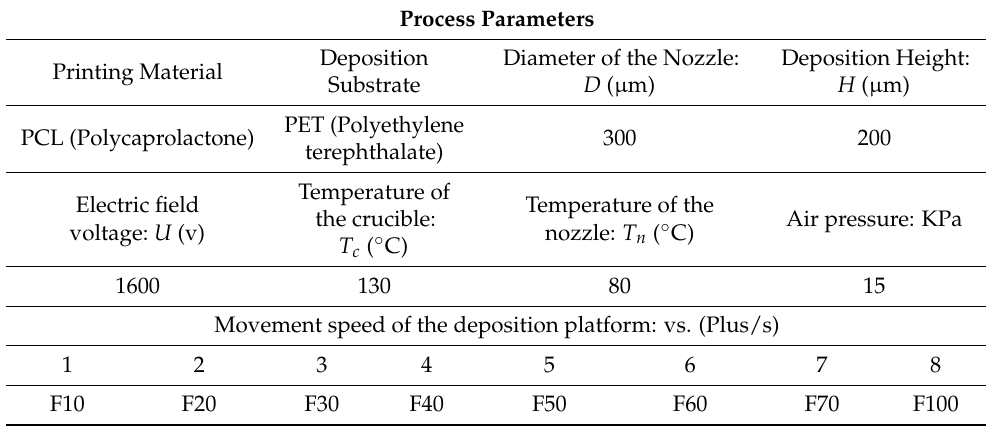
Table 1. The process parameters of printing deposition lines.